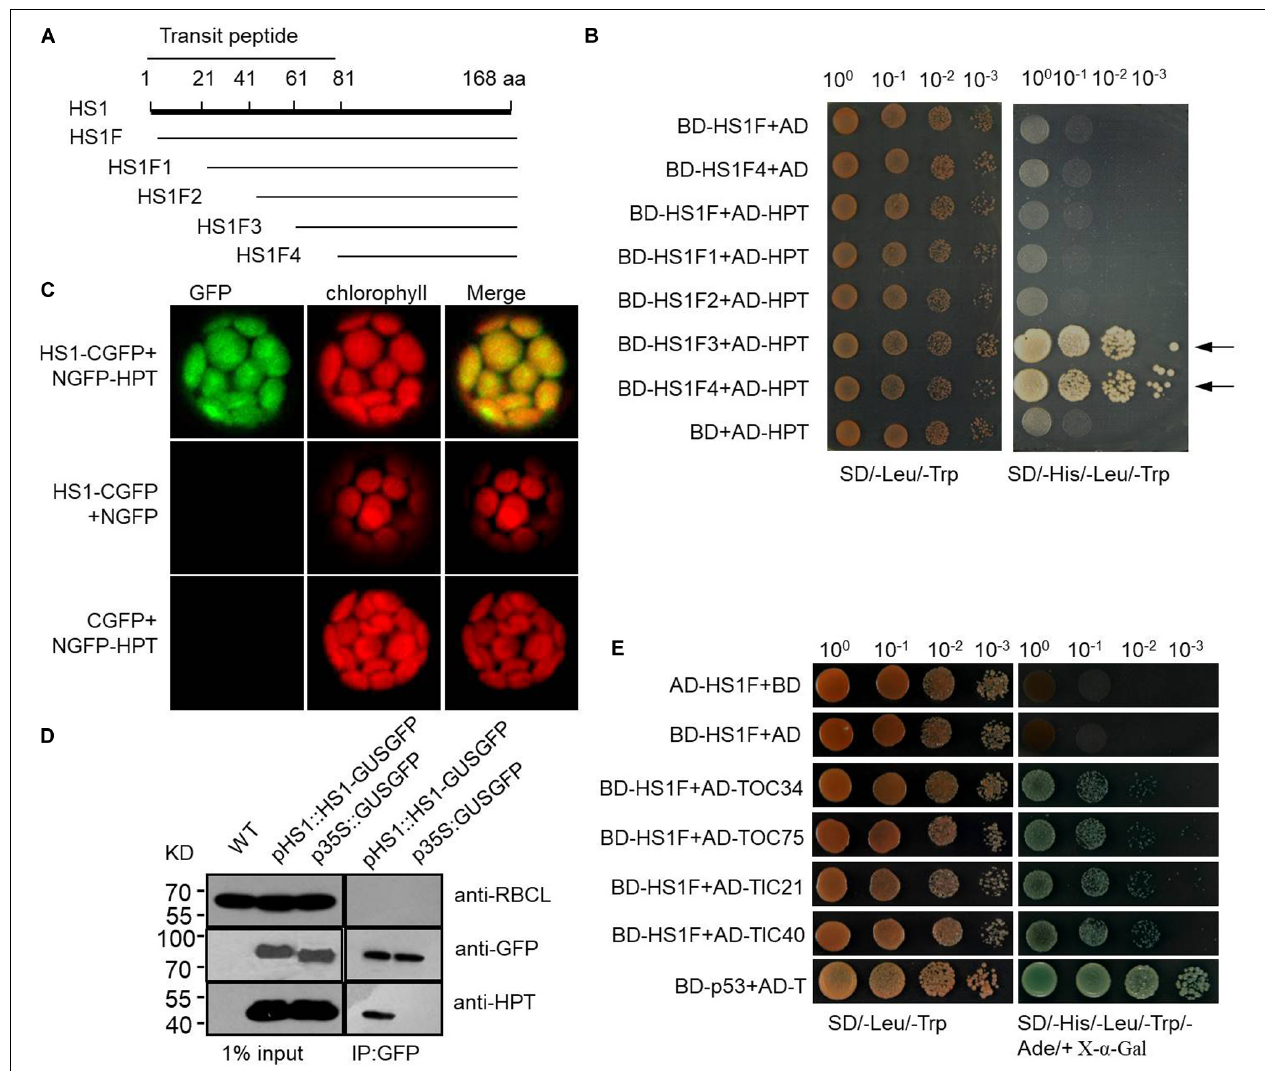
FIGURE 4 | HS1 interacts physically with HPT and with endogenous chloroplast proteins. (A) Schematic of HS1 proteins truncated from the N -terminus every 20 amino acids. HS1F1–F4 has N -terminal deletions of HS1 as shown. (B) Yeast two-hybrid assay showing HS1 interaction with HPT. Plasmid constructs used for co-transformation are indicated on the left. (C) Bimolecular fluorescence complementation (BiFC) assay. HS1 and HPT were fused to NGFP and CGFP (NGFP and CGFP are N -terminal and C -terminal fragments, respectively, from split GFP) and transiently co-transformed into plant cells. GFP fluorescence was detected in chloroplasts (top). (D) Co-immunoprecipitation assay showing interaction between HPT and HS1. Arabidopsis total proteins were extracted from 10-day-old WT and transgenic Arabidopsis seedlings. Proteins were first immunoprecipitated with anti-GFP antibody then analyzed by immunoblot with antibody against HPT. HPT was detected only in the IP products from HS-GUSGFP, but not GUSGFP plants. The large subunit of RUBISCO (RBCL) and GFP were probed as controls. Constructs used to transform plants are indicated on the top of each panel. (E) HS1 interacts with TOC/TIC complex proteins. Various proteins with AD fusion are used in a yeast two-hybrid assay with BD-HS1F ( Figure 4A ) as the bait, four proteins from the TOC/TIC complex (TOC34, TOC75, TIC 21, and TIC 40) were fused to AD. The BD-HS1F + AD combination is used as a negative control, and interaction of BD-p53 and AD-T served as the positive control. Equivalent numbers of co-transformed yeast cells were serially diluted 10-fold and plated on SD/–Leu/–Trp medium and on SD/–His/–Leu/–Trp/–Ade/+X- α -Gal medium, respectively. Locus encoded selected proteins as follows: HS1 (AT5G55210), TOC75 (AT3G46740), TIC40 (AT5G16620), TOC34 (AT5G05000), and TIC21 (AT2G15290).